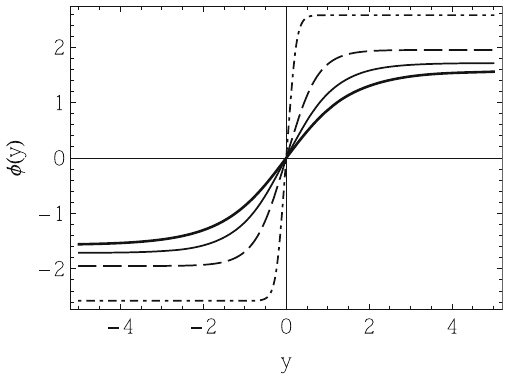
Fig. 10 Numerical plot of ϕ( y ) for ϕ (cid:2) ( 0 ) = 0, ψ 0 = 1, and ϕ 0 = 1 . 59, with n = 1 (solid line), n = 2 (dashed line) and n = 20 (dot-dashed line)